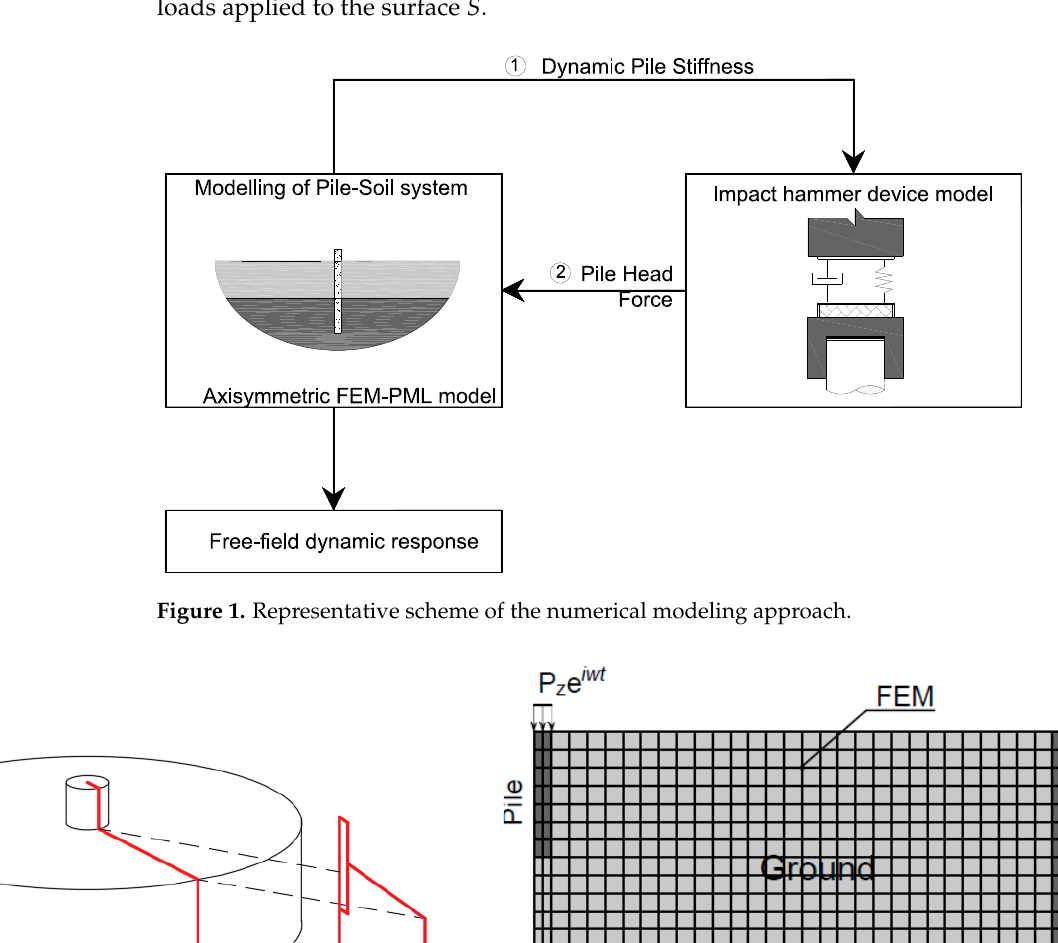
Figure 1. Representative scheme of the numerical modeling approach.